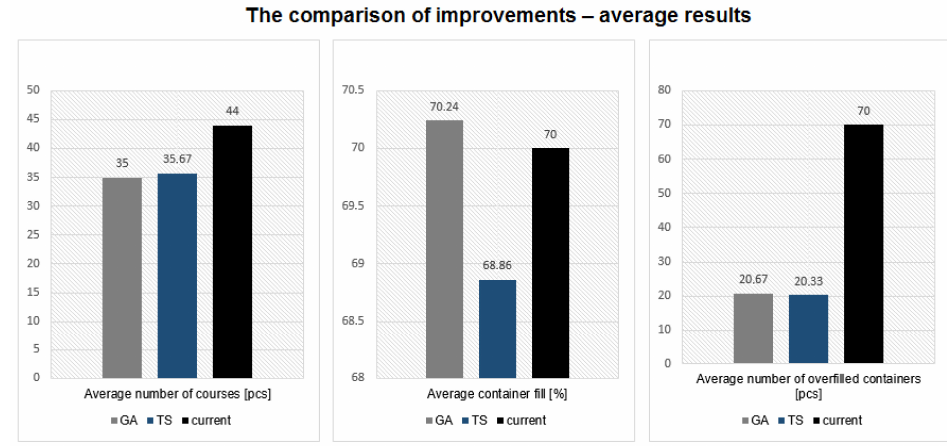
Figure 10. Improvement comparison—average results.